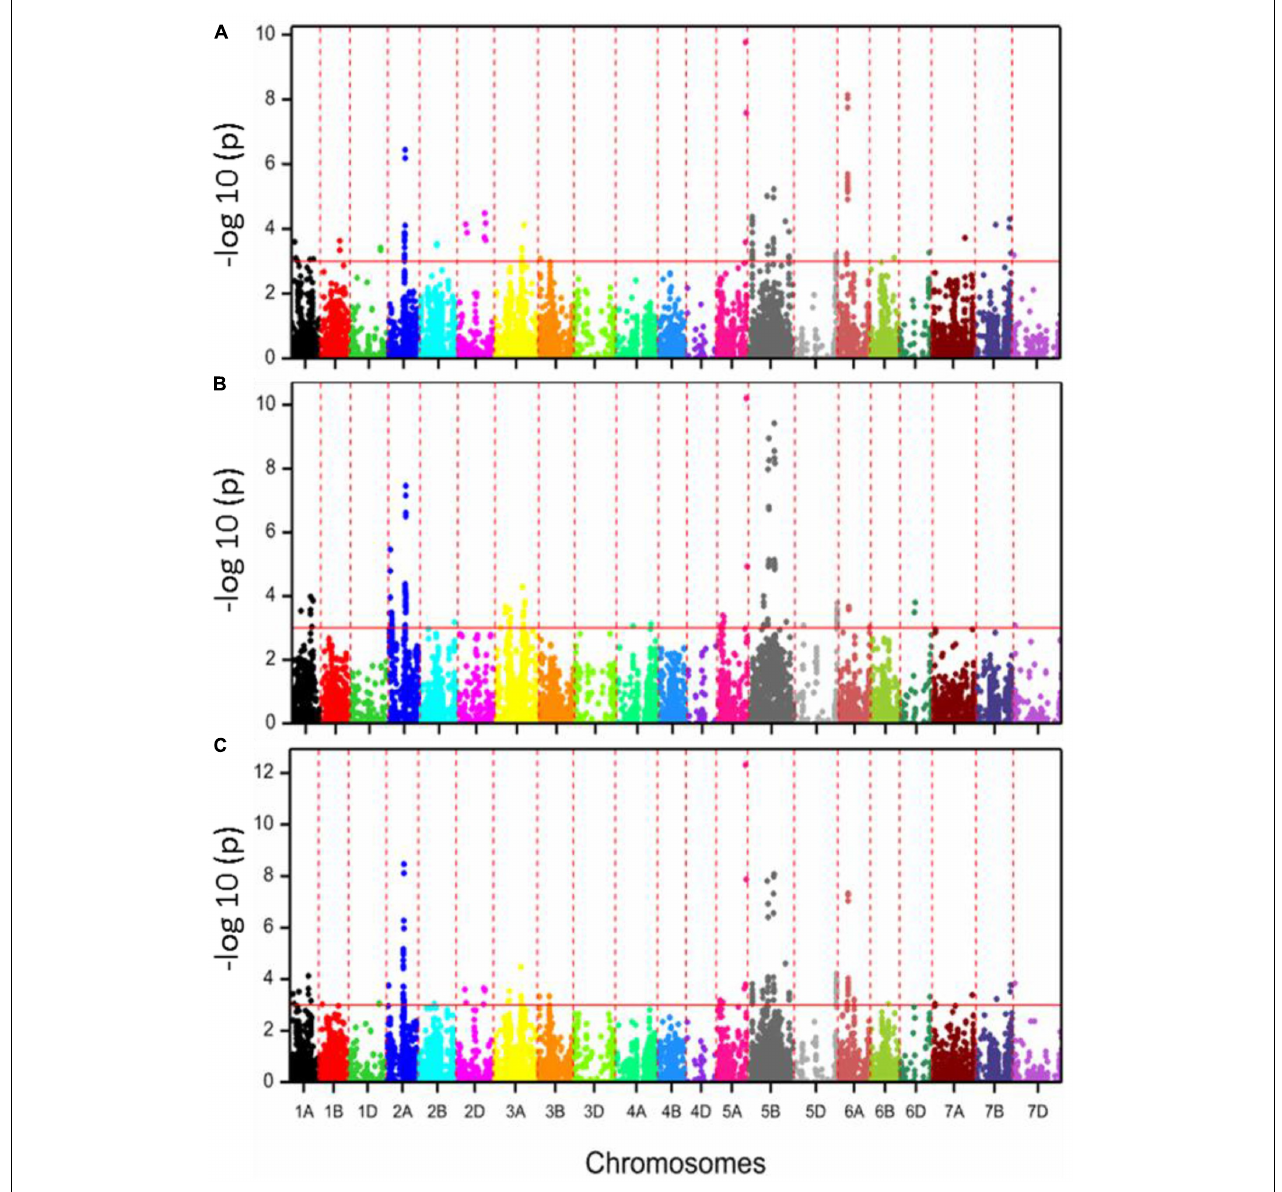
FIGURE 3 | Manhattan plots with –log P -values of SNPs associated with calcium concentration values for 353 European wheat varieties based on 2015 (A) , 2016 (B) , and BLUE values (C) . (A–C) The red line color in the figure shows the threshold of –log 10 ( P -value) of three and all the significantly associated SNP markers are above the red